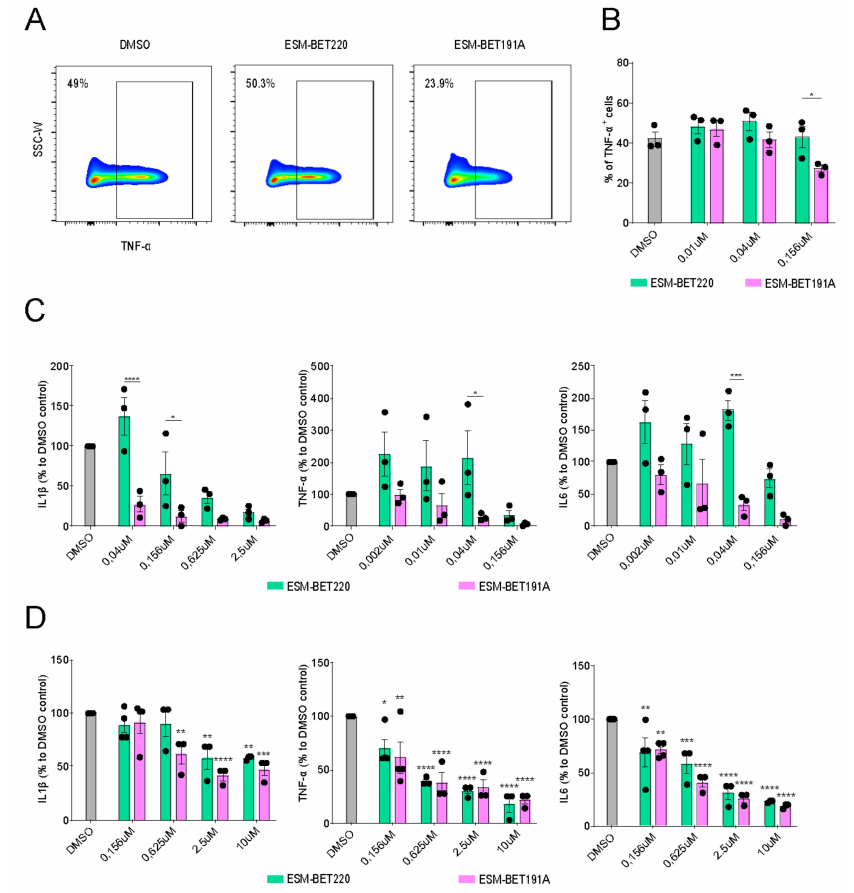
Figure 4. The capacity of ESM-iBET and its non-hydrolysable control iBET to inhibit cytokines production in healthy donor CD14 + monocytes and CD fistula tract-derived immune cells. All cell cultures were performed in a concentration range of 0.002–10 µ M, and we visualized the concentra- tions, which demonstrated a clear difference between the iBET and the ESM-iBET ( A ) Representative flow cytometry plots showing TNF expression among CD14 + monocytes in PBMCs pre-treated with DMSO, iBET GSK33611910, or ESM-iBET GSK3235220 for 1 h, followed by LPS 40 ng/mL stimulation overnight. Representative plots are shown and are pre-gated on CD14 + cells after the exclusion of dead cells, CD3 + , and CD19 + cells. ( B ) The percentage of TNF + cells among total CD14 + monocytes in PBMCs is shown (n = 3). ( C ) IL1 β , IL6 and TNF α protein secretion are measured with CBA in the supernatant of CD14 + isolated monocytes from healthy donors (n = 3), pre-treated with DMSO, iBET GSK33611910, or ESM-iBET GSK3235220, followed by LPS 10 ng/mL stimulation